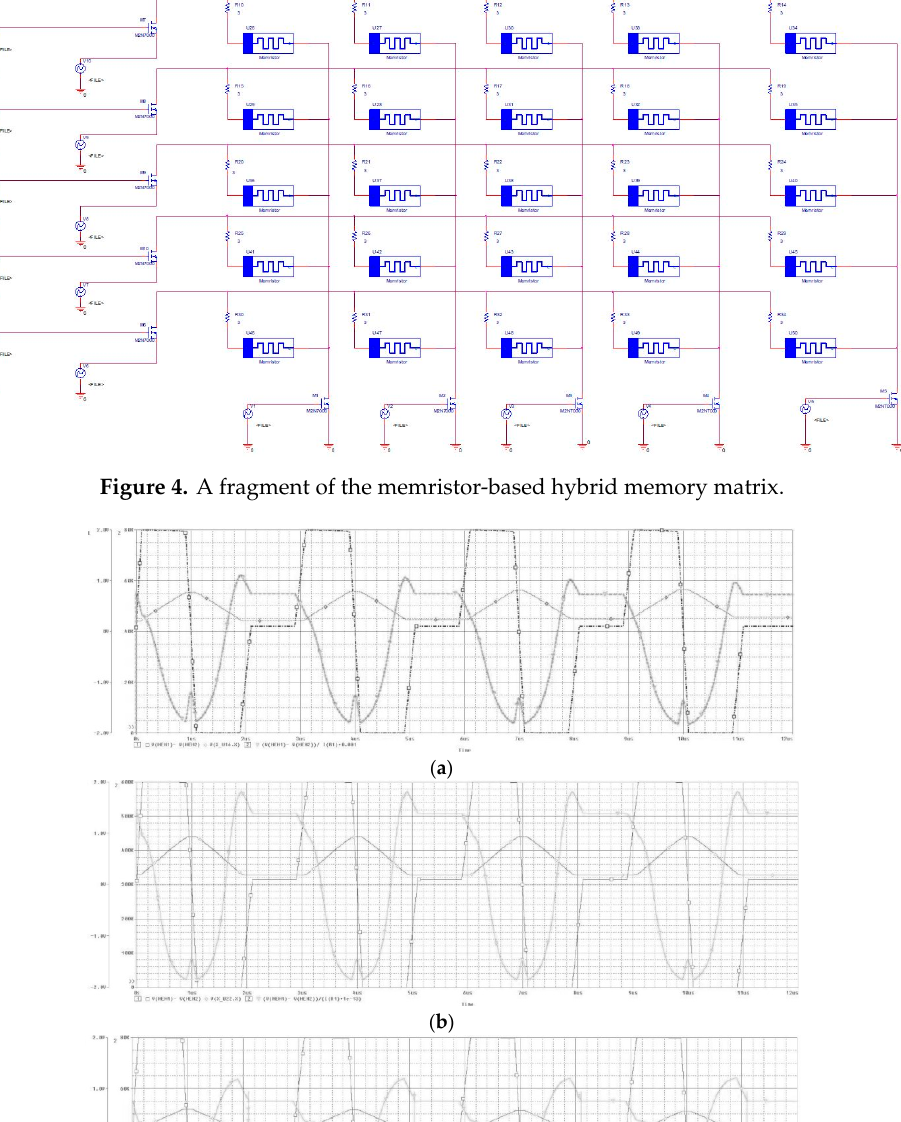
( d ) Figure 6. Current-voltage relationships of memristors in the hybrid memory crossbar for: ( a ) Biolek modified window function; ( b ) Joglekar modified window function; ( c ) Biolek original window function; ( d ) Joglekar original window function.